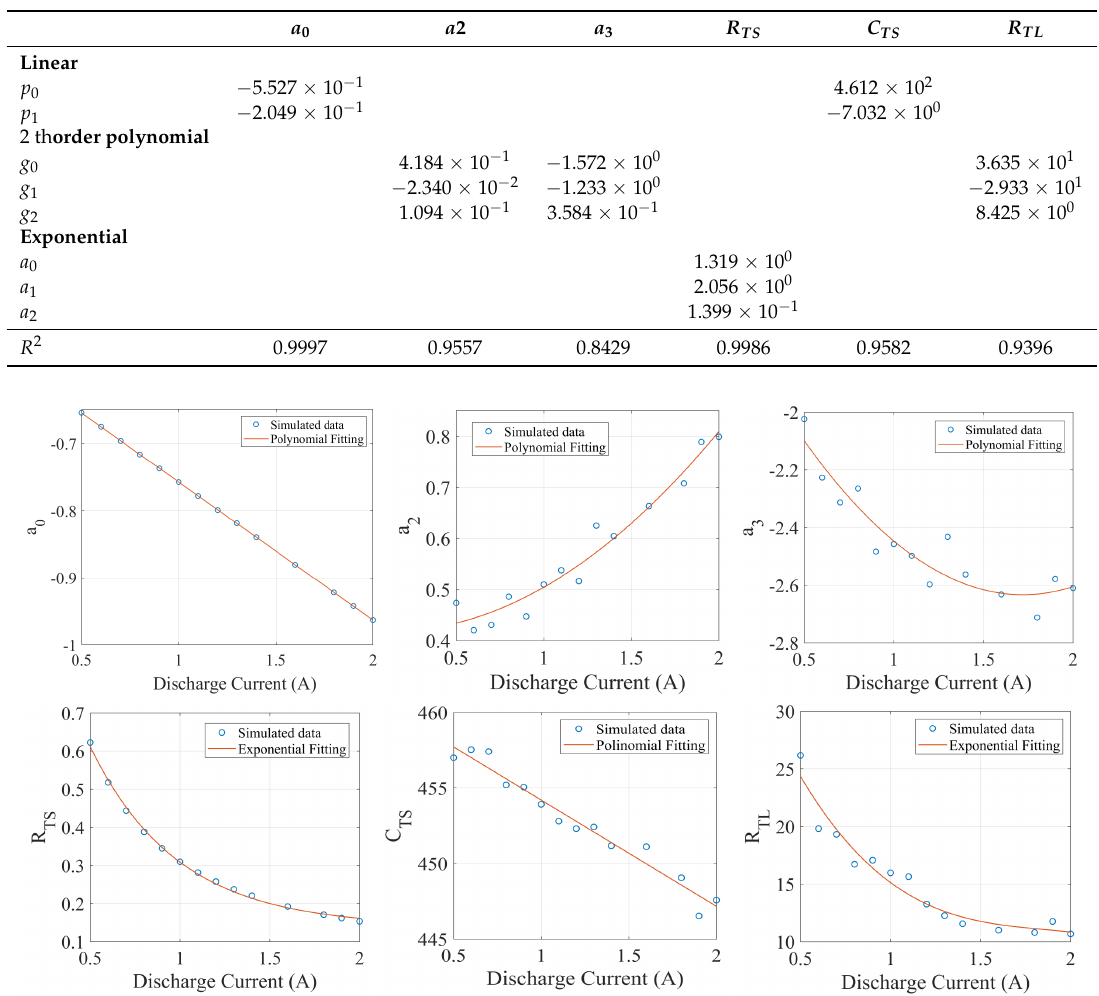
Table 3. Coefficients obtained by fitting the parameters’ trends and the respective coefficient of determination, R 2 .